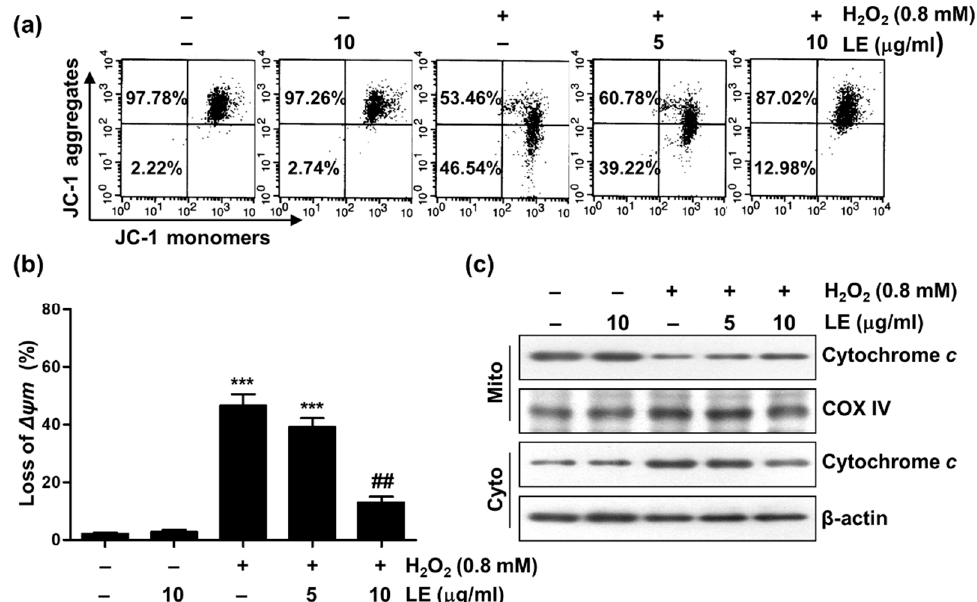
Figure 4. Effect of LE on H 2 O 2 -induced mitochondrial dysfunction in C2C12 cells. Cells were treated, with or without LE, for 1 h before treatment with 0.8 mM H 2 O 2 for 24 h. ( a ) and ( b ) MMP was stained using 5,5 ʹ ,6,6 ʹ -tetrachloro-1,1 ʹ ,3,3 ʹ -tetraethyl-benzimidazolylcarbocyanine iodide (JC-1) and then analyzed using flow cytometry: ( a ) Typical results of three independent experiments of flow cytometry are shown; ( b ) Ratio of JC-1 aggregates to monomers. Data indicate mean ± SD values ( n = 3; *** p < 0.001 vs. control cells; ## p < 0.01 vs. H 2 O 2 -treated cells); ( c ) Cytochrome c expression in mitochondrial and cytoplasmic fractions. Western blot analysis was performed using cytochrome c oxidase subunit IV (COX IV) and β -actin were as loading controls for mitochondria and cytoplasm, respectively. Representative results of three independent experiments are shown. Mito, mitochondrial fraction; Cyto, cytoplasmic fraction.